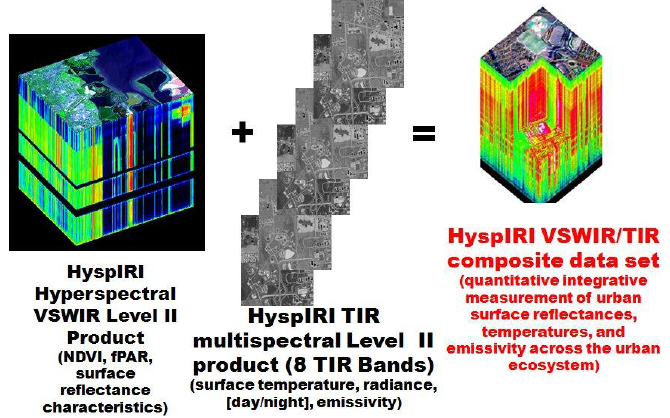
Figure 5. HyspIRI hyperspectral Visible and ShortWave Infrared (VSWIR) and thermal infrared data will provide the capability for deriving higher level integrated data products for quantitative measurement of surface reflectances and temperatures for the land surface components and material types that comprise the complex urban